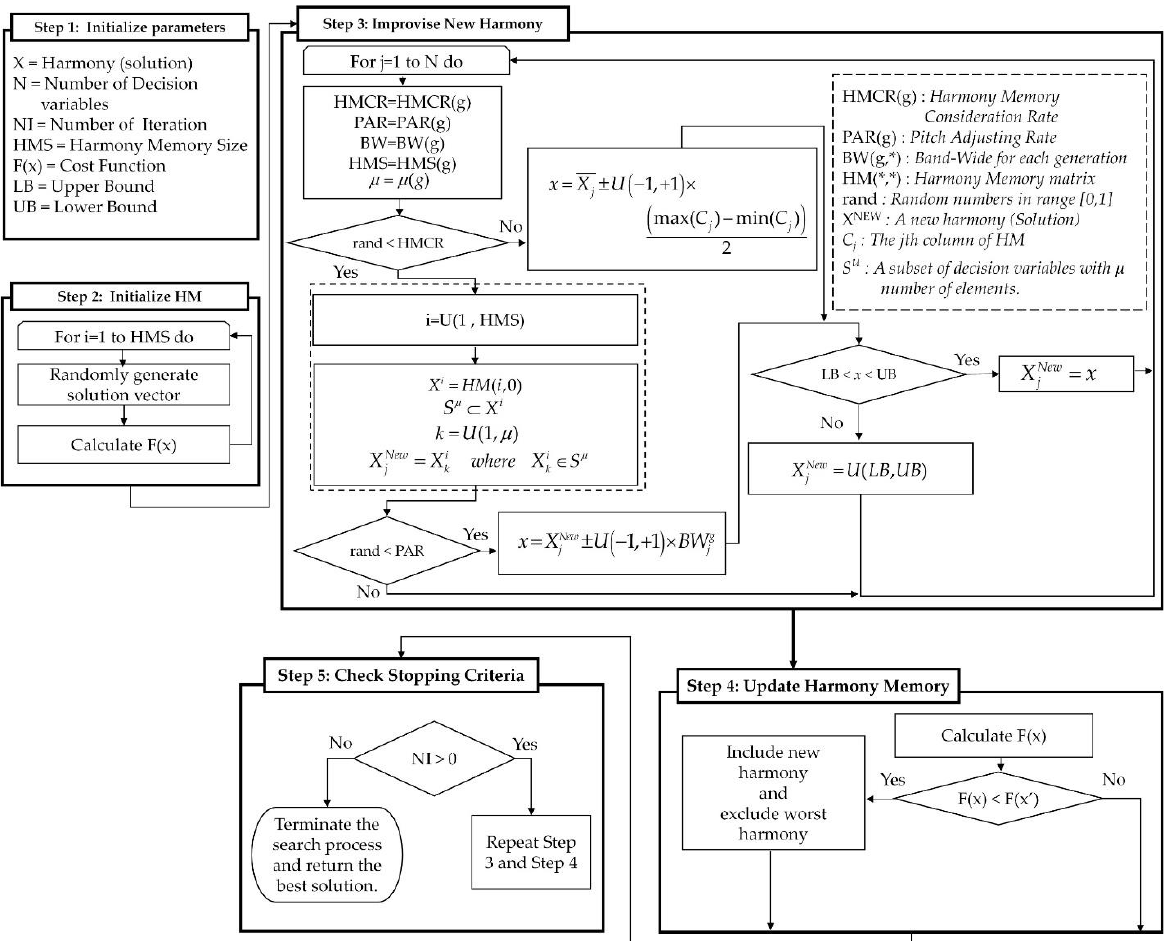
Figure 1. Full-Self-Adaptive Harmony Search (FSHS) algorithm.